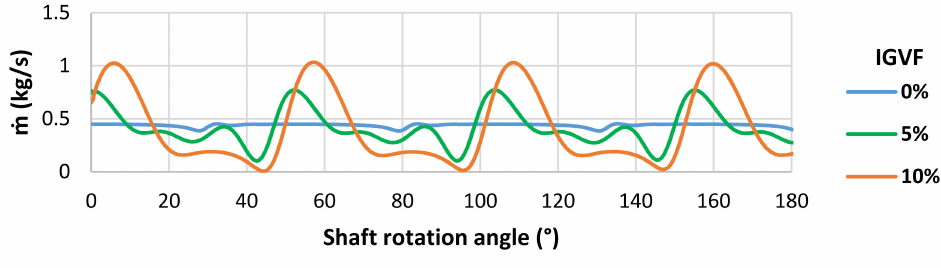
Figure 32. Outlet mass flow ripple CFD data for the TMC at p 2 = 5 bar pressure load, 20 ◦ C oil temperature and 2000 rpm at different